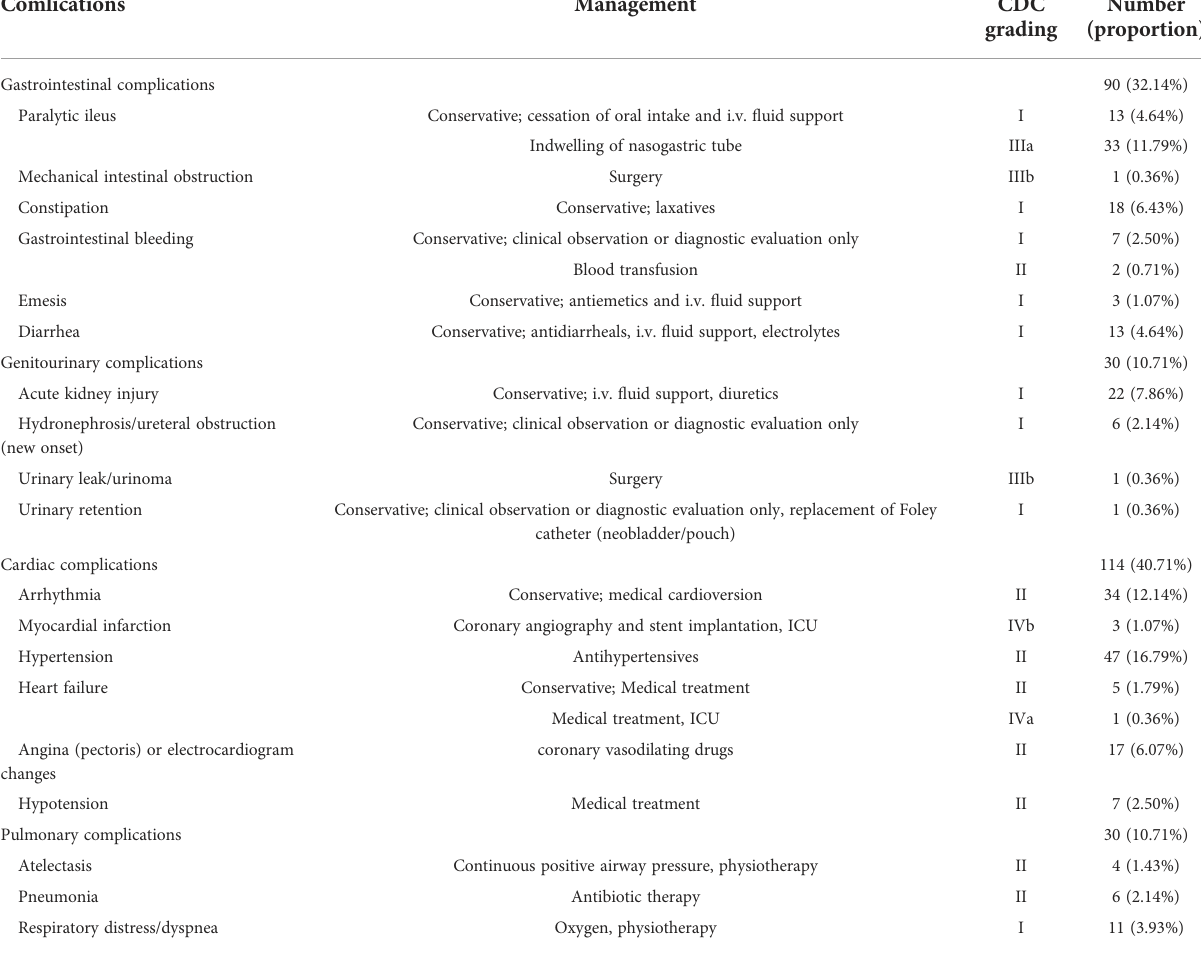
TABLE 2 Frequencies, proportions, therapeutic management, and grading of perioperative 90-d complications in patients who underwent radical cystectomy and pelvic lymph node dissection.